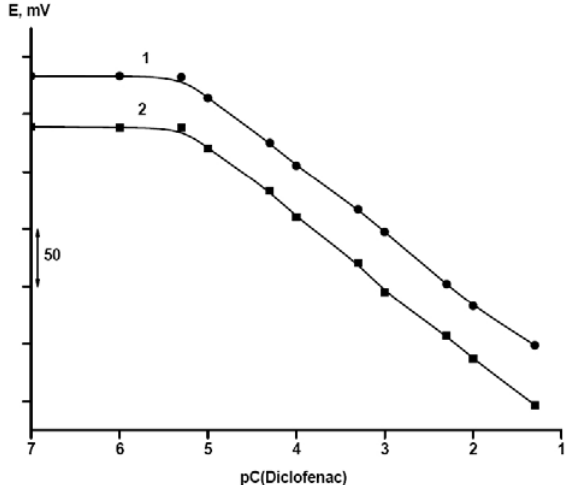
Fig. 4 Effect of the concentration of internal reference solution on the response of the diclofenac-selective electrode prepared: (1 − 1 × 10 − 2 mol L − 1 , 2 − 5 × 10 − 2 mol L − 1 of sodium diclofenac; membrane 1; pH